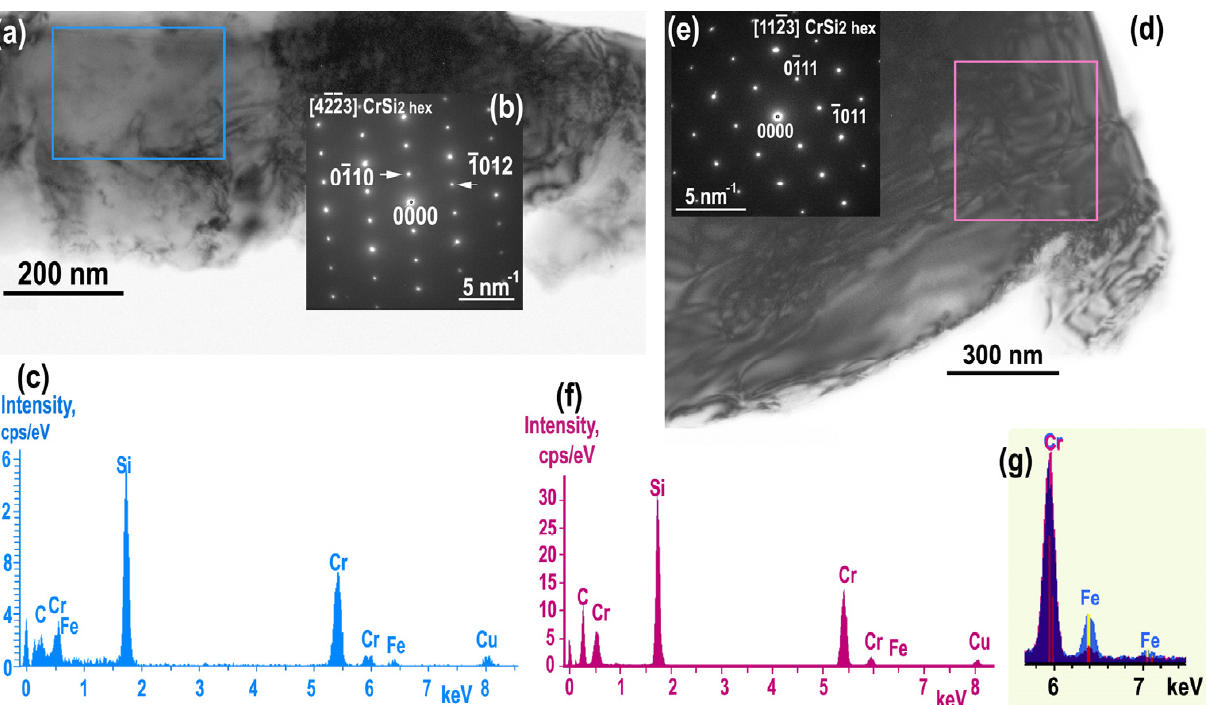
Figure 3. Comparison of CrSi 2 grain in non − annealed ( left ) and annealed ( right ) samples. TEM image ( a ) with the corresponding SAED pattern obtained along the [4223] CrSi 2 hex direction ( b ), EDXS spectrum with Fe − K α peak visible ( c ). CrSi 2 grain in annealed sample (right): TEM image ( d ) with the corresponding SAED pattern obtained along the [1123] CrSi 2 hex direction ( e ); EDXS spectrum with Fe − K α peak absent ( f ); Superimposed EDXS spectra of CrSi2 from non-annealed (light blue) and annealed samples (dark blue) after Cr − K β intensity normalization to highlight